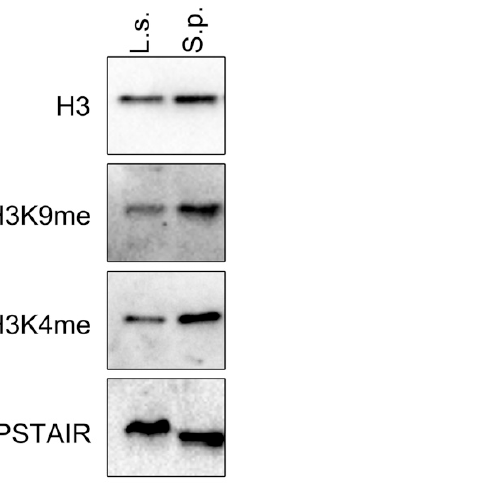
Figure 8. L. starkeyi chromatin contains H3K9me. Cell extracts prepared from L. starkeyi (L.s.) or S. pombe (S.p.) were analyzed by Western blotting. Levels of Cdc2 (anti-PSTAIR) were used as a loading control.